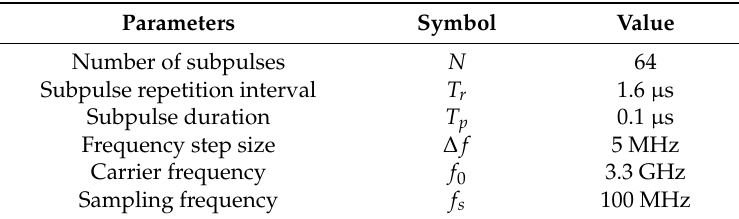
Table 1. Parameters of the S-band radar